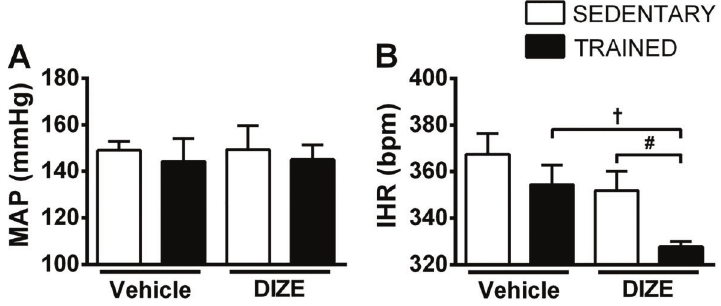
Figure 3. Means ± SE of mean arterial pressure (MAP; A ) and intrinsic heart rate (IHR; B ) of sedentary and trained rats receiving vehicle or diminazene aceturate (DIZE) after double auto- nomic blockade. #, w P o 0.05 (ANOVA followed by the Fisher LSD post hoc test).